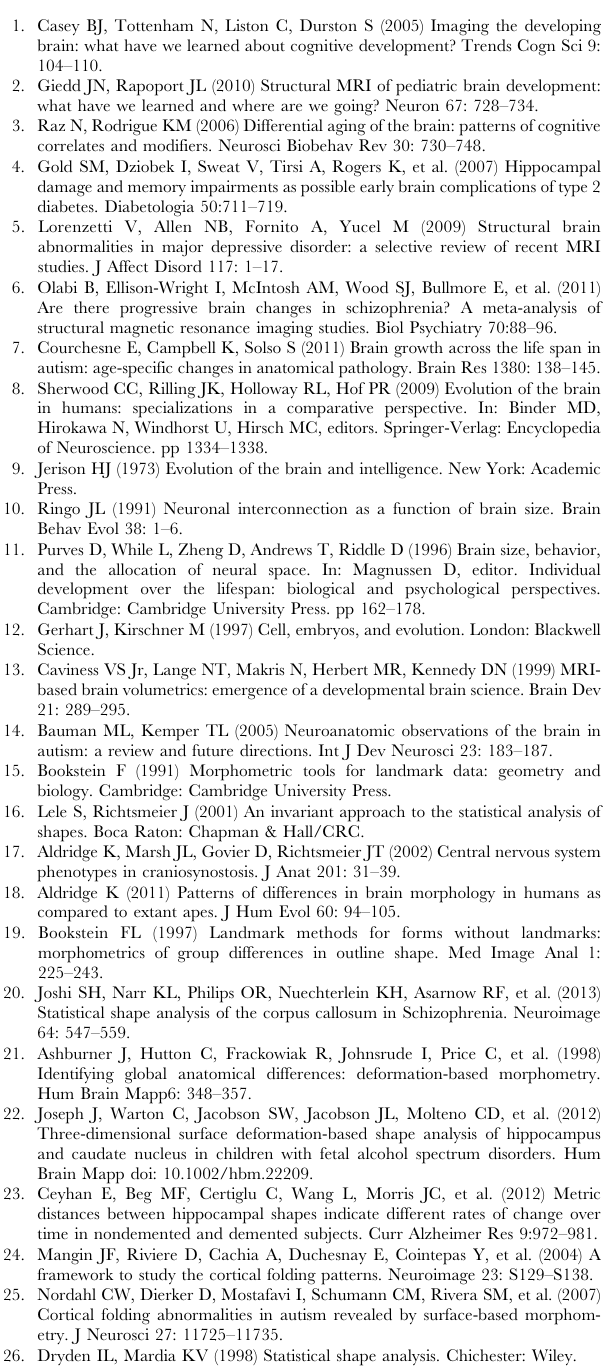
Figure S1 Landmark guide. The landmark guide includes detailed step-by-step directions for the location of the 29 landmarks assessed in this study. Table S1 Raw landmark coordinate data. This table includes the raw coordinate data for all of the landmark trials for all three